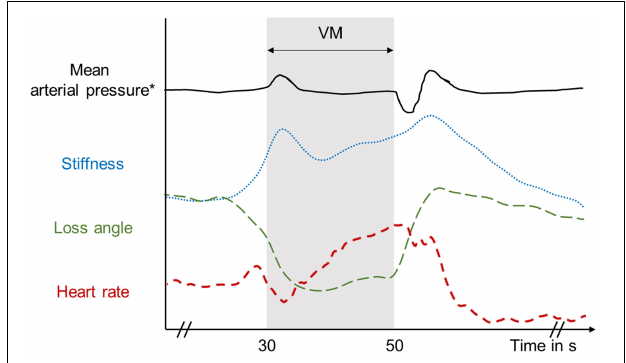
FIGURE 7 | Diagram of average viscoelastic response with typical mean arterial pressure reported by Pstras et al. (2016) and heart rate variations during and after the Valsalva maneuver with inspiration before the maneuver as measured in this